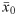
Schematic depiction of urn sampling and growth.
(a) Schematic illustration of the random initial conditions. An infinite reservoir contains a diluted mixture of bacteria, a fraction x‾0 of which are of strain A. We draw small volumes of liquid from the reservoir containing small, random numbers of individuals, which conform to a Poisson distribution with mean (determined by the dilution of the reservoir population). A certain fraction of this initial population is of strain A. The mean value of this fraction is equal to x‾0. We use these individuals to initiate populations in the wells of a microtiter plate, so that each population starts with a random size N
0 and a random fraction of A-individuals x
0. (b) Illustration of the Pólya urn model. If a bacterial population is represented as an urn, each individual as a marble and each bacterial strain as a color, this urn model captures the essentials of bacterial reproduction in our populations. At each iteration, a marble is drawn at random and returned to the urn, together with another one of the same color. The probability of extracting a marble of either color is determined solely by its relative abundance, making the process non-selective (since no strain has inherent advantages, see S2 Table). The rate of growth in population size can be rendered exponential (see S2 Fig) by letting the waiting time between successive iterations be exponentially distributed (also known as Poissonization).